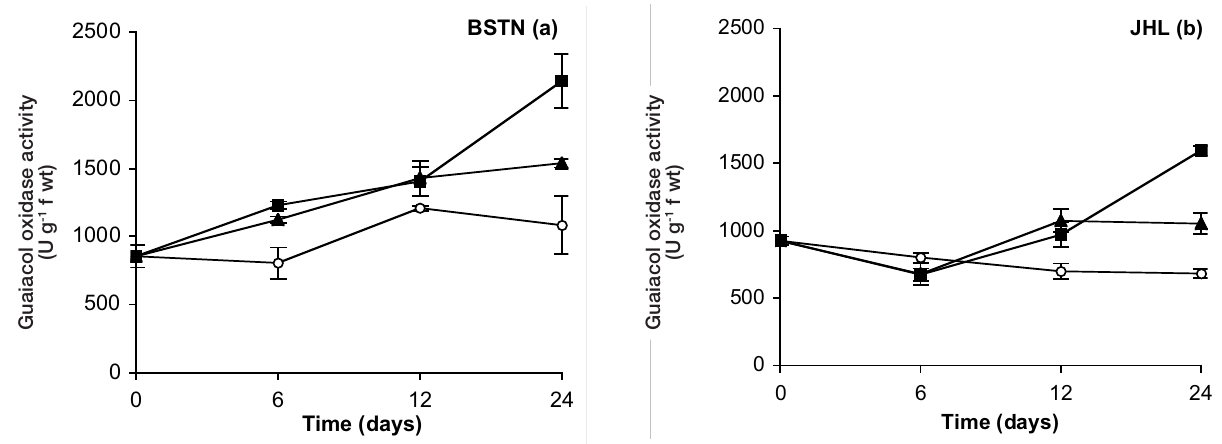
Fig. 2. Guaiacol oxidase activity in date palm seedling roots cv. BSTN (a) and JHL (b) after inoculation with Fusar- ium oxysporum f. sp. albedinis ( Foa ) ( ▲ ); treatment with jasmonic acid ( ■ ); distilled water control ( O ).